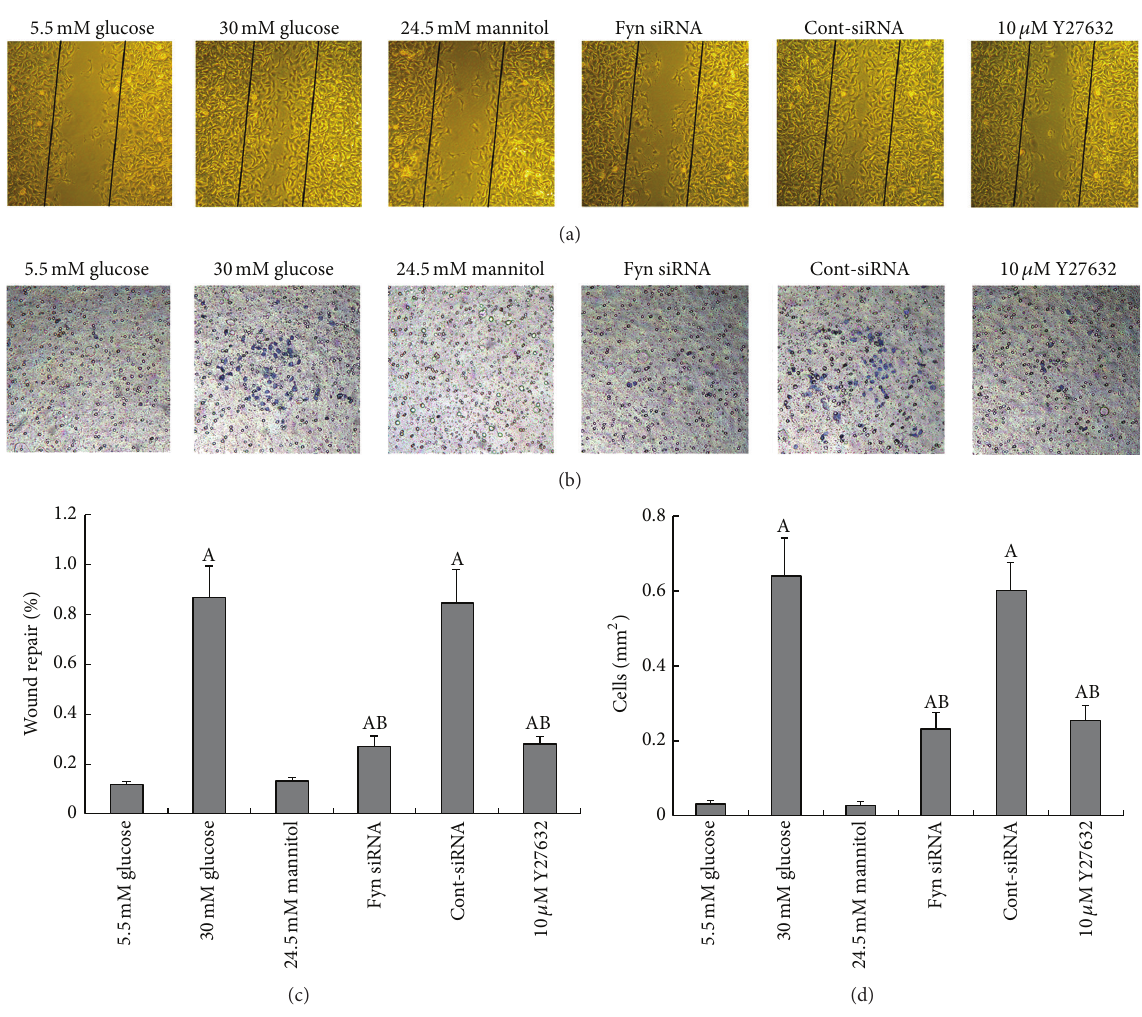
Figure 10: Podocyte motility by wound-healing assay and transwell migration assay. The wound-healing assay (a) and the modified transwell migration assay (b) were performed. Podocytes showed little migration when incubated in 5.5 mM glucose (column 1). Stimulation with 30 mM glucose-induced increased migration of podocytes (column 2), which was partially decreased by transfection with Fyn siRNA for 48 hours (column 4) or pretreatment with 10 𝜇 M Y27632 for 30 minutes (column 6). Control podocytes were treated with Cont-siRNA (column 5) or 5.5 mM glucose plus 24.5 mM mannitol (column 3). Magnification: